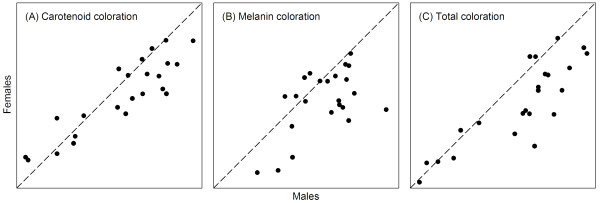
Male and female coloration scores. Relation of male and female scores for carotenoid coloration (A), melanin coloration (B) and total coloration (C). Dashed diagonals represent perfect sexual monochromatism (1:1 lines). Species at the lower left area of the plot are sexually monochromatic and little ornamented, at the upper right area are monochromatic and very ornamented, and towards the lower right area are dichromatic with males more ornamented than females.